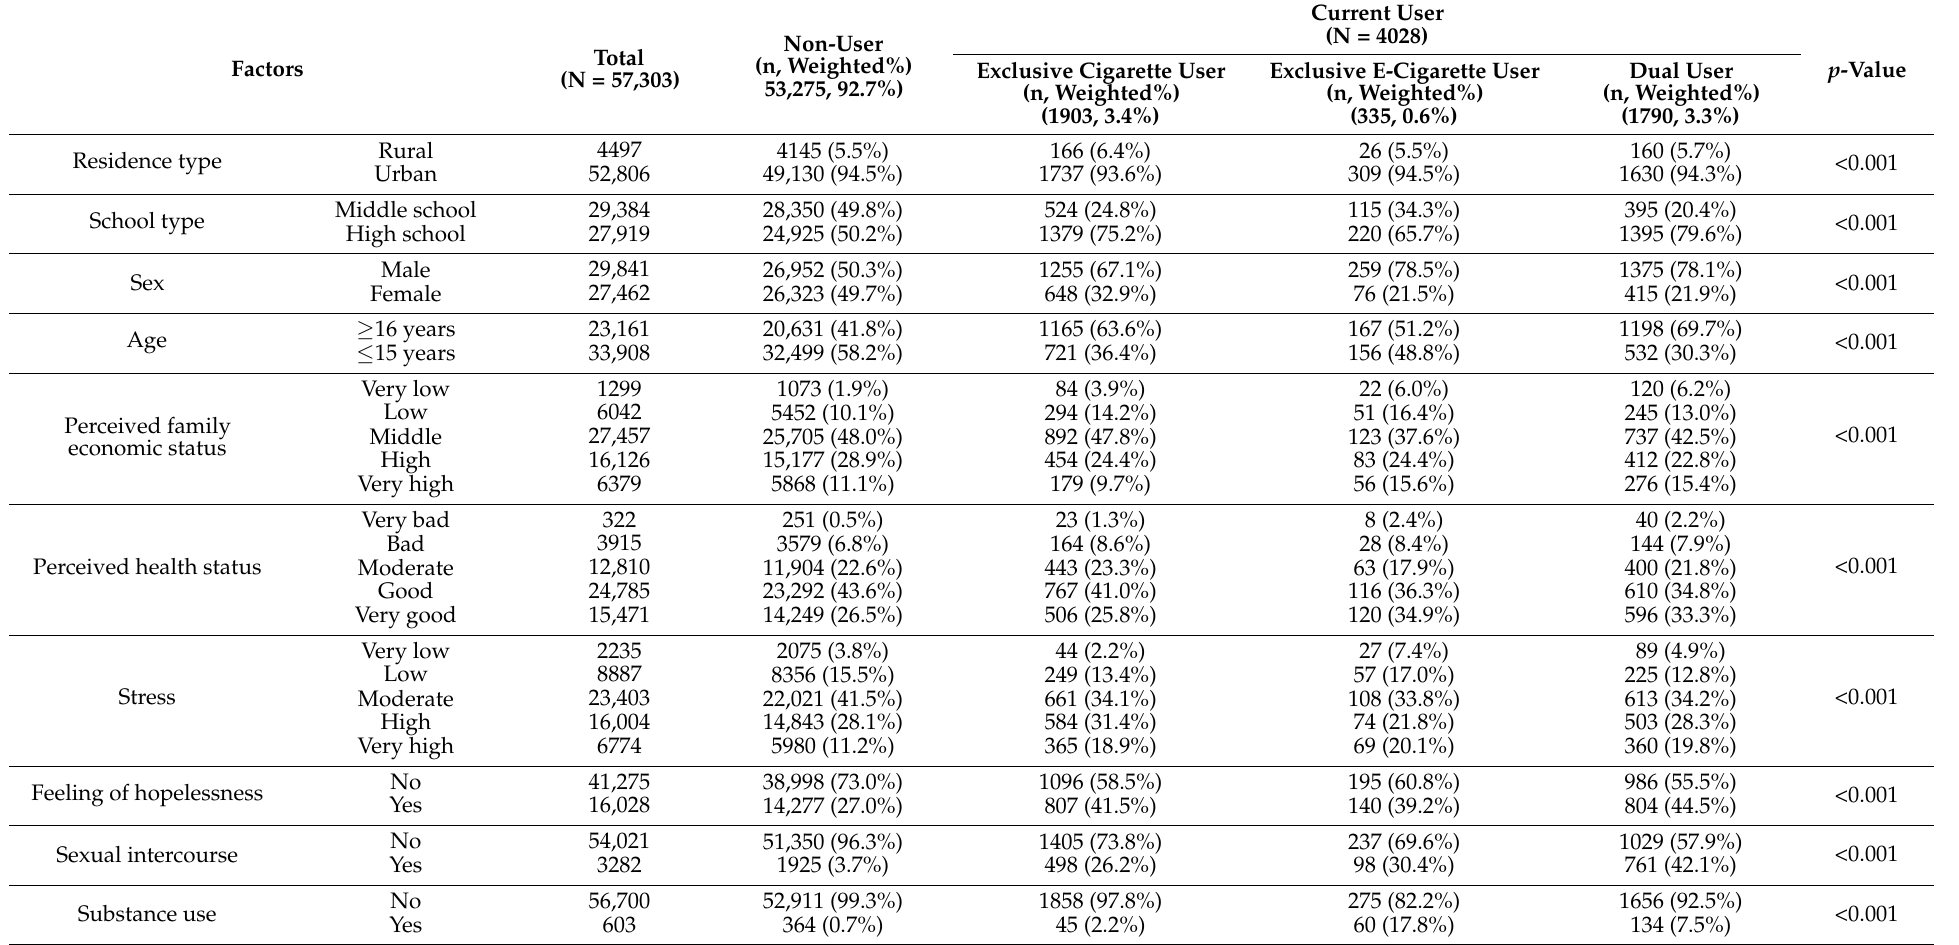
Table 1. Socio-demographic characteristics of participants (N =